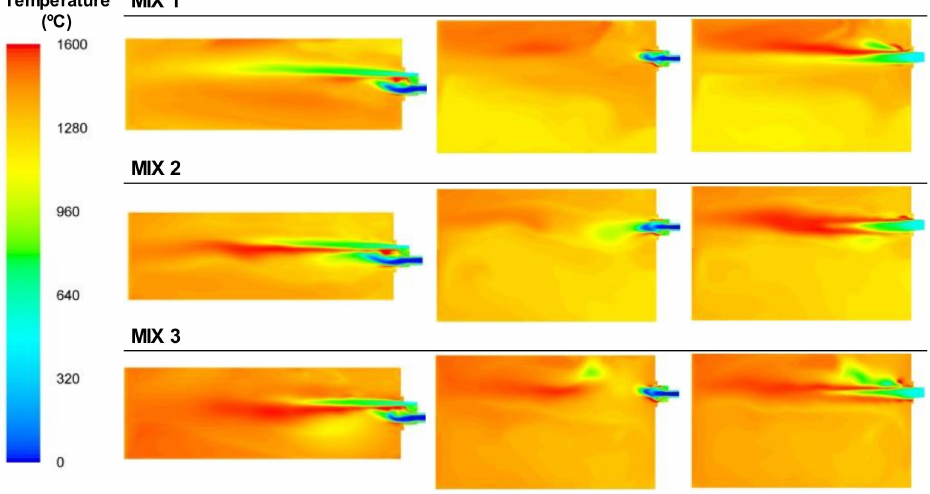
Figure 18. Contour plots of temperatures for the BFG/NG mixture cases in the XZ1, XY1, and XY2